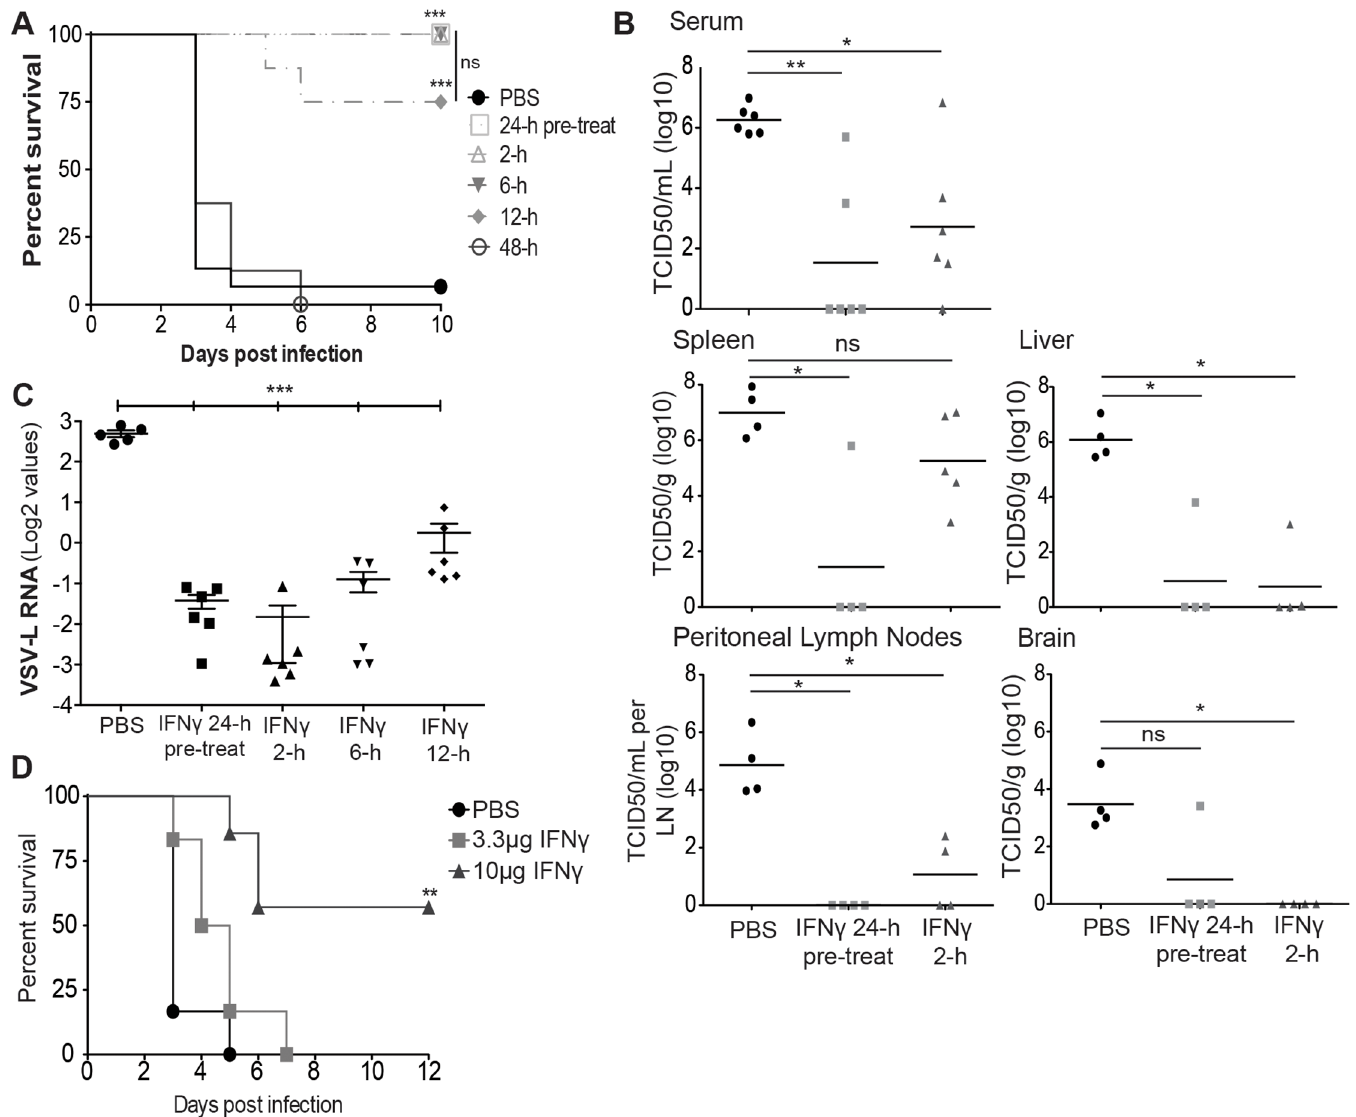
Fig 5. IFN γ reduces EBOV-GP/rVSV morbidity and mortality. (A) IFN γ enhances survival of EBOV GP/rVSV infected mice. IFN γ (10 μ g) or PBS was administered by i.p. injection to BALB/c IFNAR -/- mice 24 hours prior to or 2, 6, 12 or 48 hours following EBOV GP/rVSV infection (n (cid:1) 8/treatment). (B) IFN γ treatment as a 24 hour pre-treatment or a 2 hour post-treatment reduces serum viremia and organ titers of EBOV GP/rVSV-infected mice. Sera and organs were harvested at 48 hours following infection (n (cid:1) 4/treatment) in mice treated with 3.3 μ g of IFN γ . Viremia and organ virus titers were determined by endpoint dilution of serum or homogenized organ samples on Vero cells. Significance was calculated by Mann-Whitney test compared to PBS control, * p < 0.05, ** p < 0.01. ns, not significant. (C) Intraperitoneal IFN γ treatment of mice significantly inhibits EBOV GP/rVSV infection of peritoneal cells. Peritoneal cells were isolated from EBOV GP/rVSV infected mice treated with 3.3 μ g of IFN γ at times noted prior to or following challenge. Amount of VSV-L RNA was determined by qRT-PCR. Significance was determined by ANOVA with a Tukey post-test, *** p < 0.001. (D) Intramuscular administration of IFN γ increases survival of IFNAR -/- mice. PBS or IFN γ at the indicated concentration was administered by i.m. injection 24 hours prior to i.p. injection of EBOV GP/ rVSV. For A & D, significance was determined by Mantel-Cox Test, ** p < 0.01, *** p <